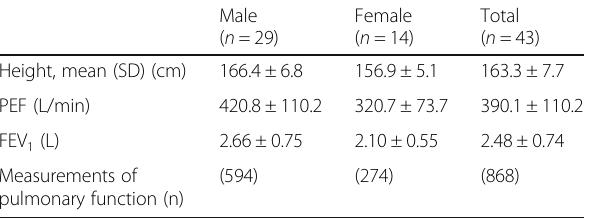
Table 1 Characteristics of study